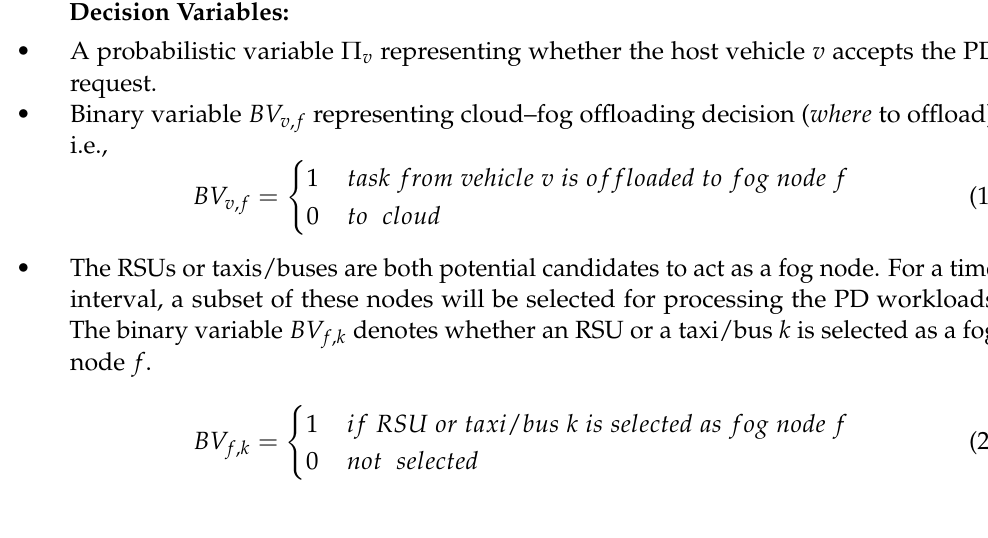
Figure 3. An overall framework of power consumption-delay trade-off in a VFC system. Decision